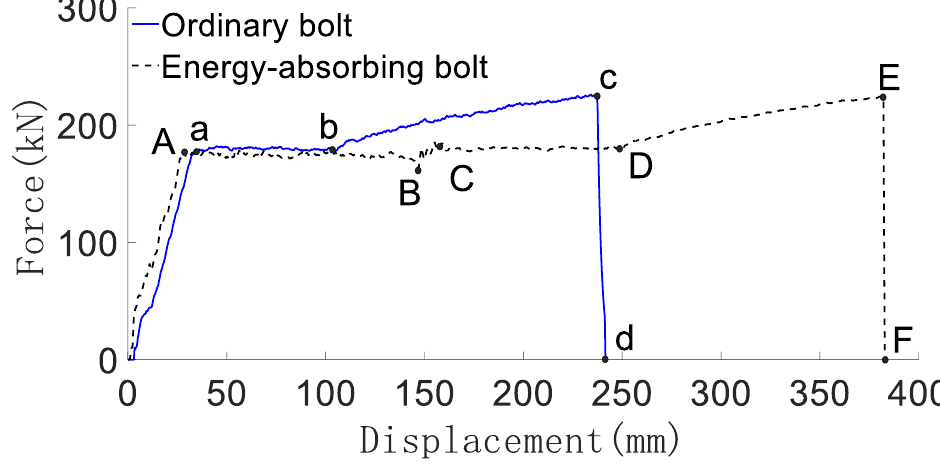
Figure 5. Anchor force-displacement curve.